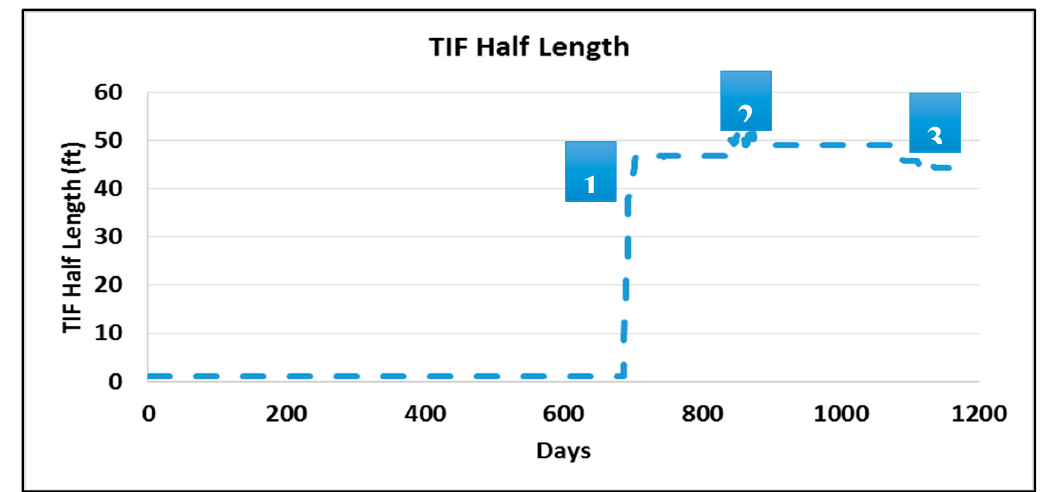
Figure 42. Evolving TIF half-length throughout the entire injection period.